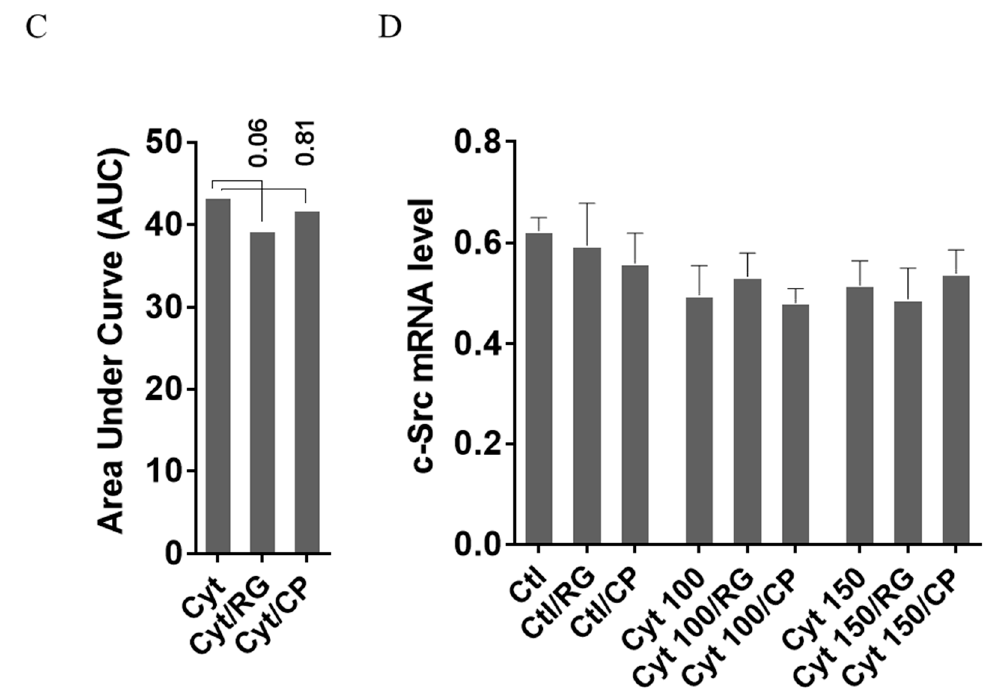
Figure 4. Rotigaptide reduces nitroxidative stress in INS-1 cells. INS-1 cells were pre-incubated with or without 100 nM rotigaptide (RG) or control peptide ZP119 (CP) for one hour in the presence or absence of cytokine mixture for 24 h ( A ), 6 h ( B , D ), or in a time course of 5, 10, 15, 20, 25, 30, or 45 min ( C ). ( A ) Accumulated nitrite was measured with Griess reagent in the supernatant. ( B , D ) iNOS and c-Src mRNA levels were determined by qPCR. The expression of iNOS and c-Src normalized to HPRT1 was calculated with − ∆ Ct. ( C ) Immunoblot analysis of the time course of cytokine-induced IkB α degradation in the presence or absence of RG or CP was quantified with ImageJ software and normalized to tubulin. Data are means ± SEM of n = 6 (for A , B , D ) / n = 3 (for C ) independent experiments. * ≤ 0.05, ττ ≤ 0.01, τττ ≤ 0.001, ττττ ≤ 0.0001. The symbols τ and * indicate the Bonferroni-corrected paired t-test values of cytokine (Cyt) exposure versus control (CTL) and Cyt exposure versus exposure to Cyt and RG, respectively. NS: not significant. AUC: area under curve, NO: nitric oxide, iNOS: inducible nitric oxide synthase, HPRT1: Hypoxanthine-guanine phosphoribosyltransferase 1.